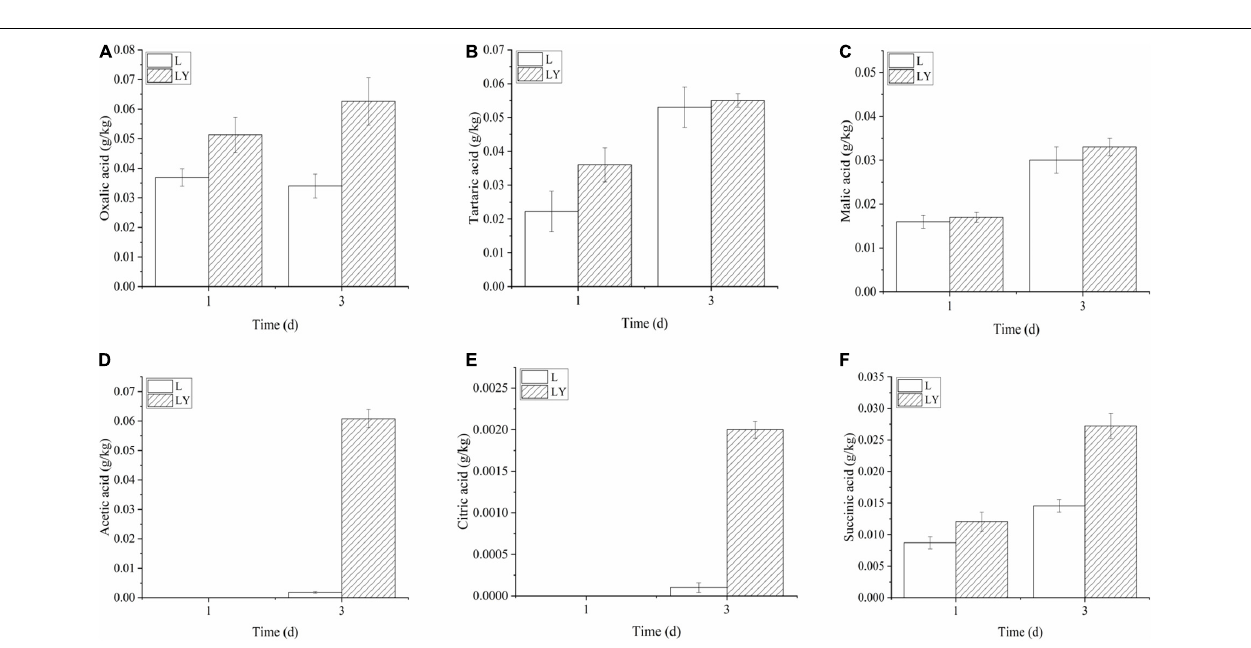
FIGURE 1 | The variations of the number of L. paracasei (A) and the concentration of L-lactic acid (B) in the fermentation period of 1 and 3 days of rice-acid inoculated with L. paracasei and mixed-culture with L. paracasei and K. marxianus (L means rice-acid inoculated with L. paracasei , LY means rice-acid inoculated with L. paracasei and K. marxianus ).